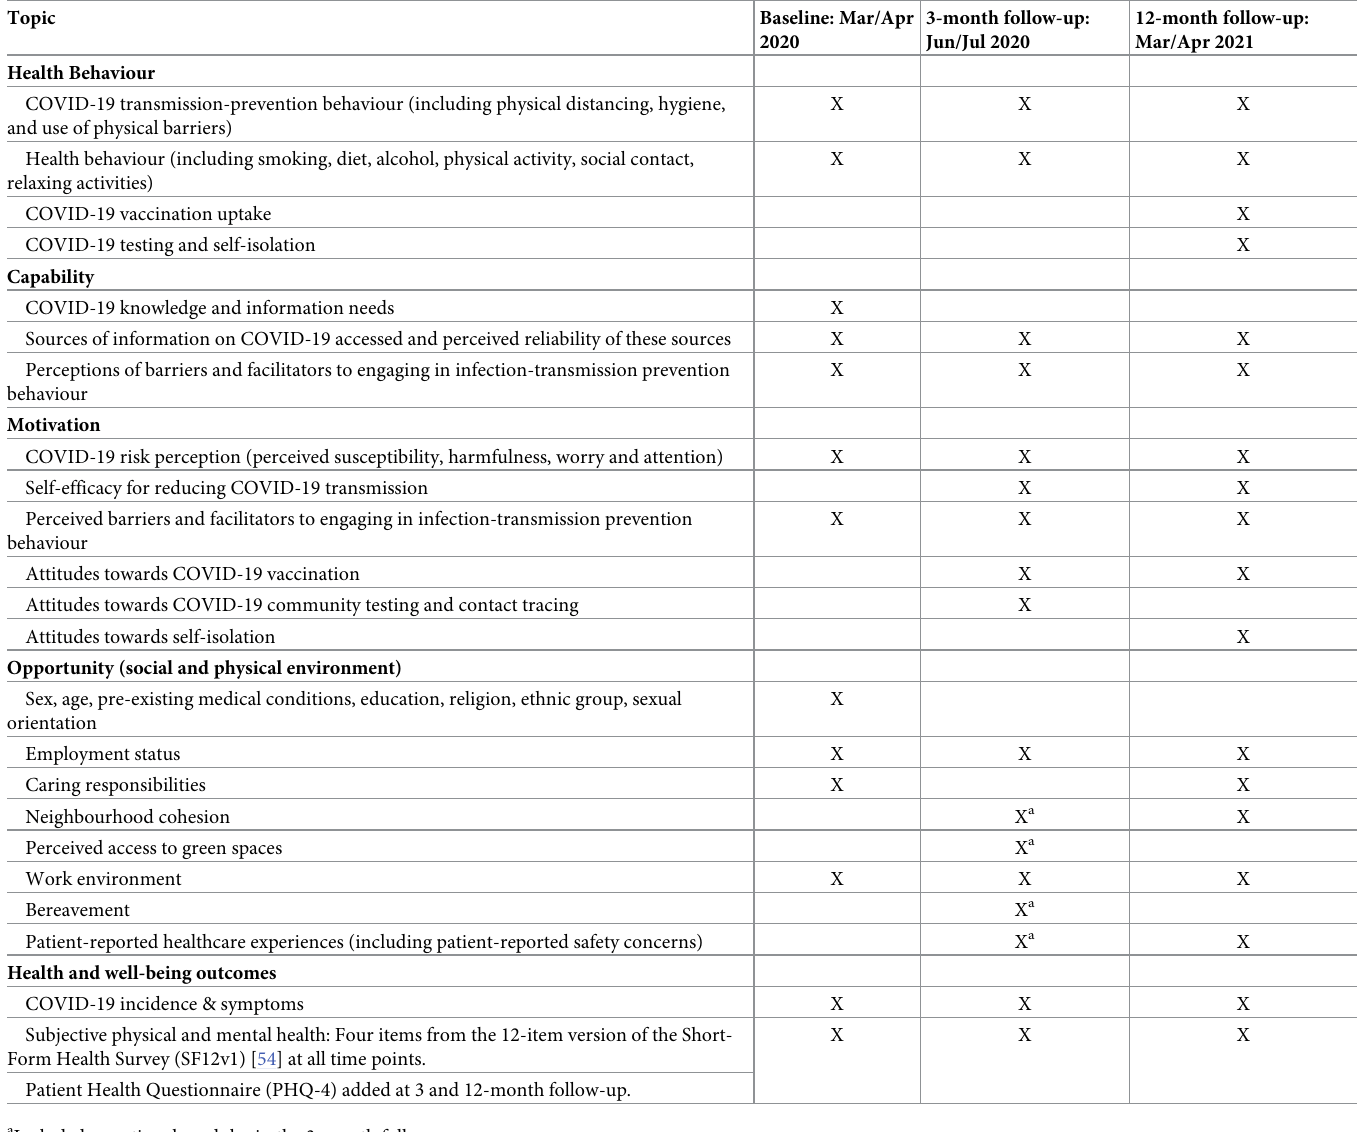
Table 1. Summary of topics covered at each time point of the COPE longitudinal survey.